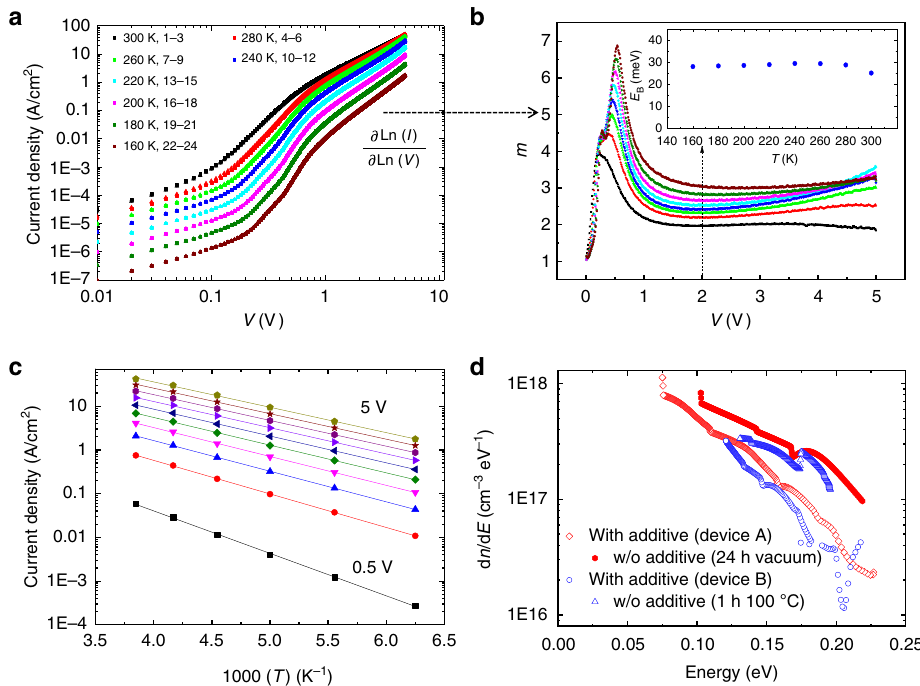
Fig. 2 Density of trap states in poly[[2,5-bis(2-octadecyl)-2,3,5,6-tetrahydro- − 3,6-diketopyrrolo[3,4- c ]pyrrole-1,4-diyl]-alt-(2-octylnonyl)-2,1,3- benzotriazole] (DPP-BTz) space charge-limited conduction (SCLC) diodes. a Log – Log J – V characteristics of a DPP-BTz diode ( d = 220 nm) with a solvent additive (1,2-dichlorobenzene (DCB)) measured at temperatures between 300 and 160 K; each characteristics was recorded three times to exclude degradation. b Corresponding power law exponent, m ¼ ∂ Ln ð I Þ ∂ , of the SCLC characteristics as a function of temperature. The colors of the individual curves Ln ð V Þ correspond to those in a . The width of the trap distribution ( E B ) is estimated from Eq. 2 from the extended plateau (2 V) and is shown as an inset for all temperatures. c Arrhenius-type temperature activation of the current density for voltages between 0.5 and 5 V. d d n /d E values extracted for DPP-BTz devices with and without an additive. The d n /d E is shown for two separate devices (device A with a thickness of 170 nm and device B with a thickness of 220 nm), with the additive removed by annealing (blue) or by extended storage in vacuum